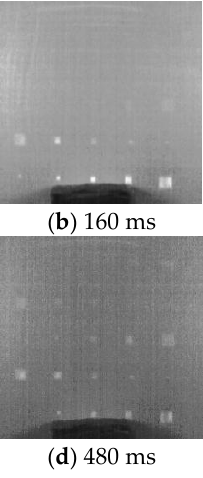
Figure 6. Raw thermograms.